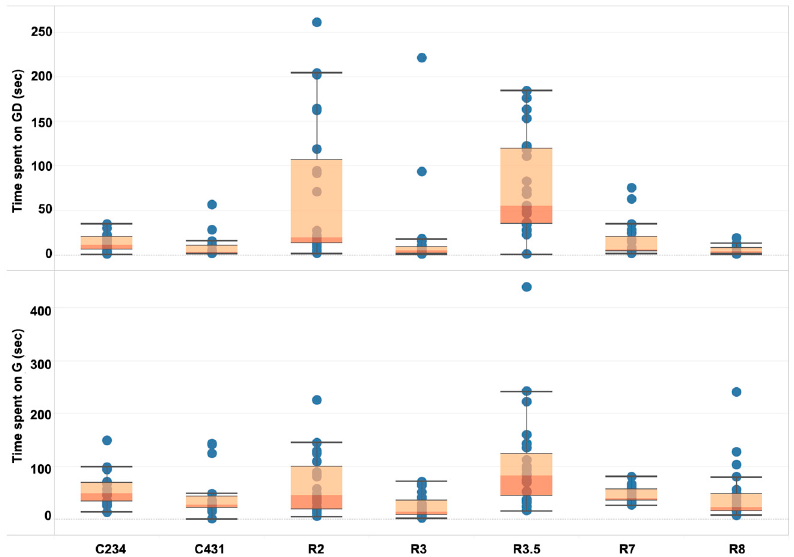
Figure 5. Boxplot of students’ time spent on gesture development and the gesturing of each task. Each boxplot includes the information of the minimum, first quartile, median, third quartile, and maximum (from bottom). Each circle represents a single student.